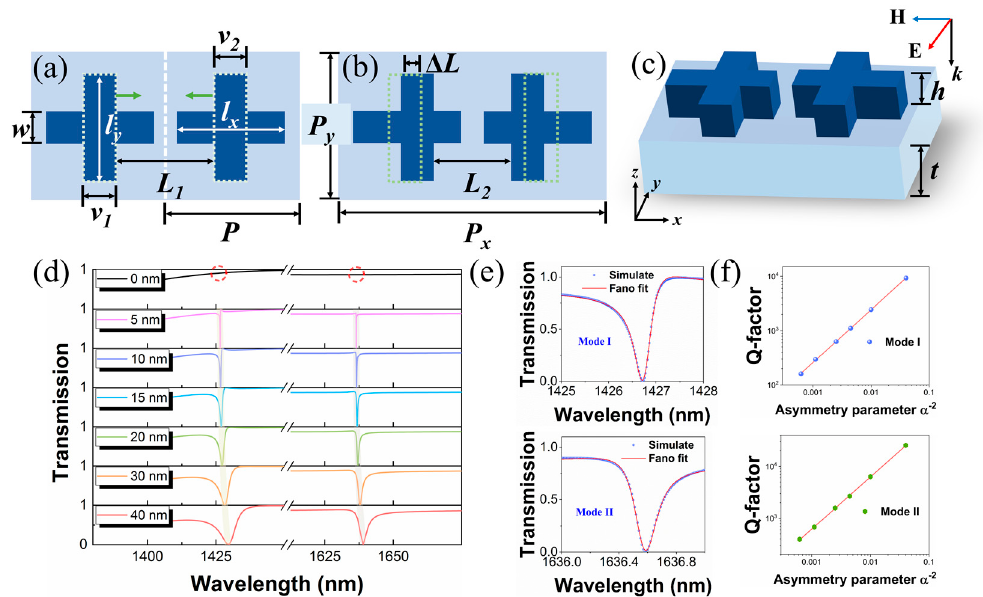
Figure 1. Schematic of the proposed metasurface. ( a ) Original structure of the unit cell. The diagram shows two adjacent unit cells. P = 600 nm, L 1 = 450 nm, w = v 1 = v 2 = 150 nm, l x = 500 nm, and l y = 600 nm. ( b ) The dimer metacell of the metasurface after introducing perturbation. L 2 = 430 nm, P x = 2 P = 1200 nm, and P y = 800 nm. ( c ) h = 300 nm, and t = 1000 nm. The incident light is a linearly y-polarized plane wave. ( d ) Transmission spectra with varying Δ L values. The symbols at the top of the spectra mark the positions of BICs. ( e ) Fano fit curves for the simulation results of modes I and II when Δ L is 10 nm. ( f ) Log–log plots of Q factors with respect to the growing asymmetry parameter for modes I and II.